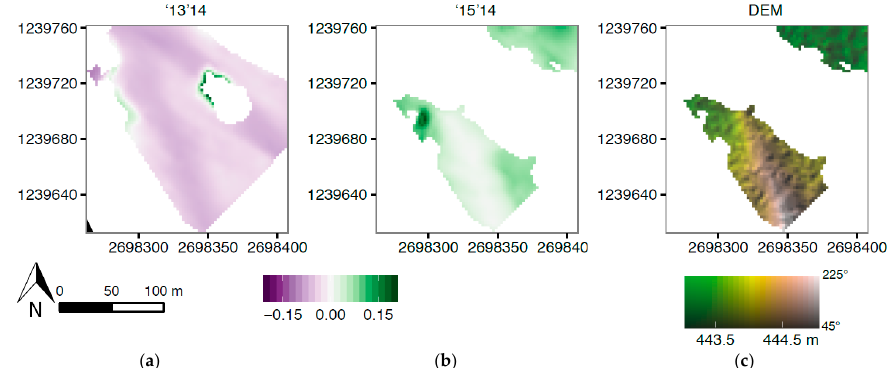
Figure 7. SMPE values for: ‘13’14 ( a ); and ‘15’14 ( b ); and DEM (overlaid with a hillshade: 315° azimuth and 45° altitude) for an individual agricultural field ( c ). Figure 6. Spatial distribution in the focus area of the SMPE values for: ( a ) ‘13’14; and ( b ) ‘15’14.